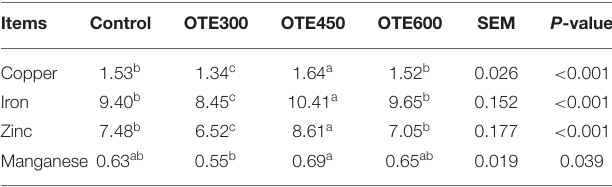
TABLE 6 | Effects of dietary organic trace elements supplementation on serum trace elements in late-phase laying hens ( µ